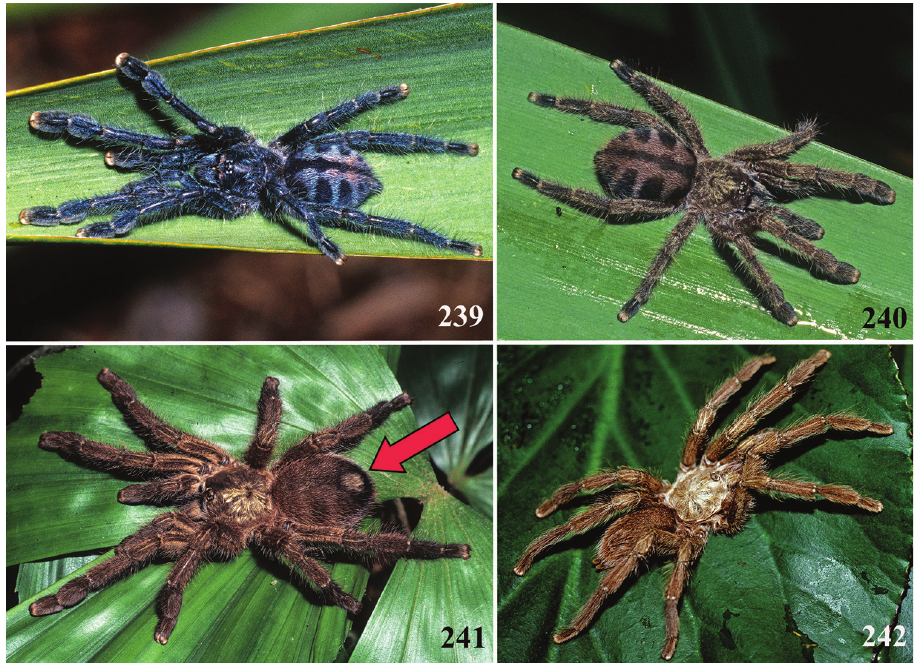
eter from margin. Legs: Formula: IV=I II III. Length leg IV to leg I: 0.98. Metatarsus III scopulate in distal 2/3; IV, in distal